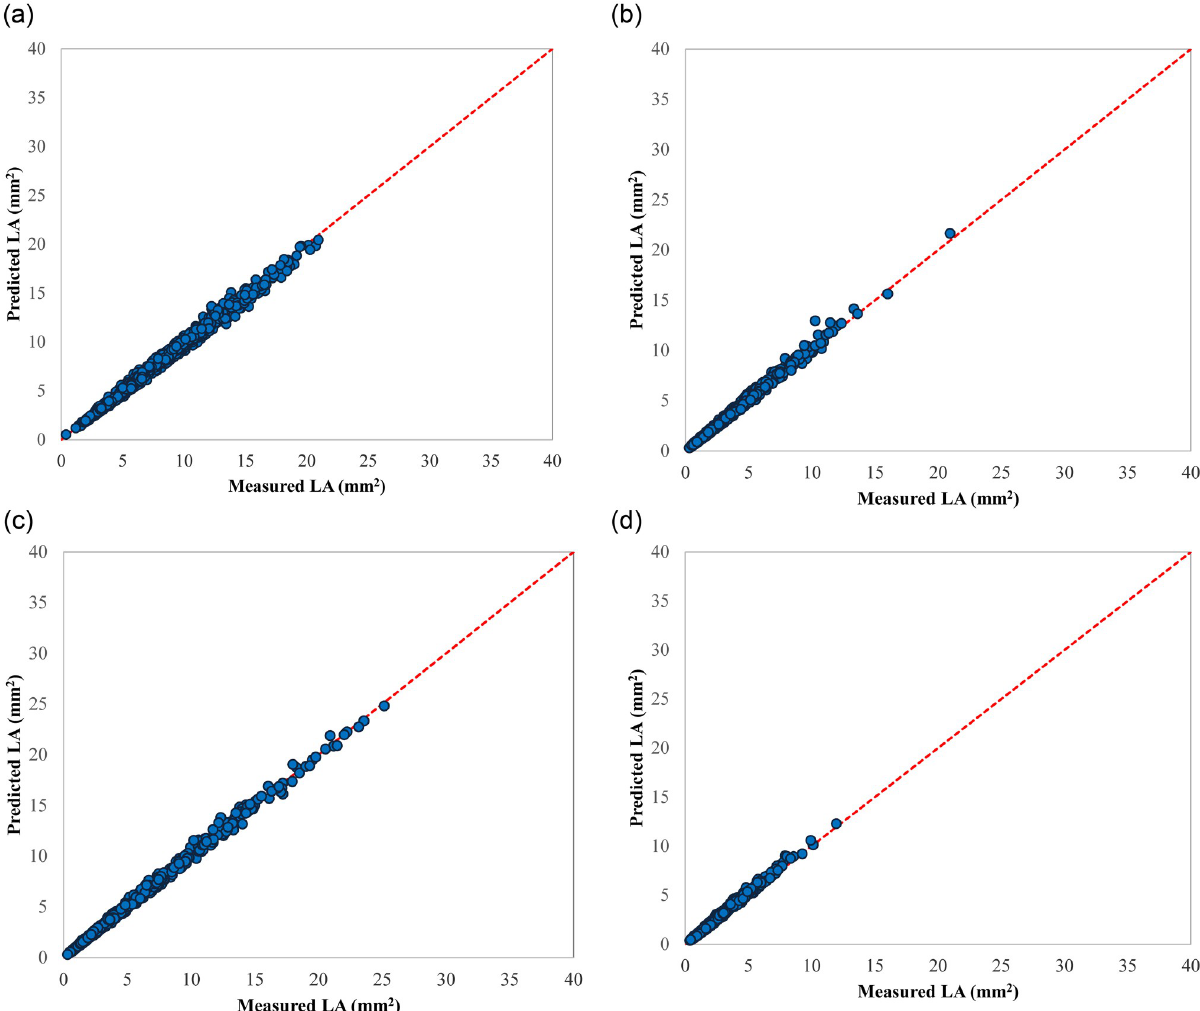
Fig 5. Scatter plots of the estimated LA values by LA = 0.007 + 0.687 L × W model (developed by 2019 data) vs. the corresponding measured LA values of 2021 dataset for different genotypes; a) Gavali, b) Ghandi, c) Shahryari, and d)